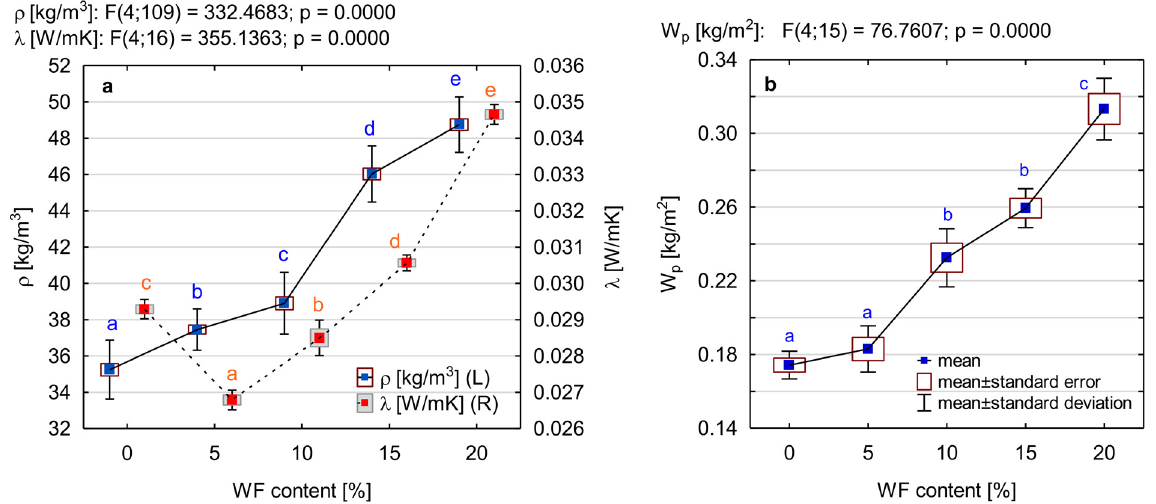
Figure 6. Effect of wood filler addition on: ( a ) apparent density ( ρ ) and thermal conductivity ( λ ), ( b ) short-term water absorption by partial immersion (W p ) of PUR composite foams. Different letters in colour indicate homogeneous groups of mean values determined by one-factor ANOVA with Tukey’s test.